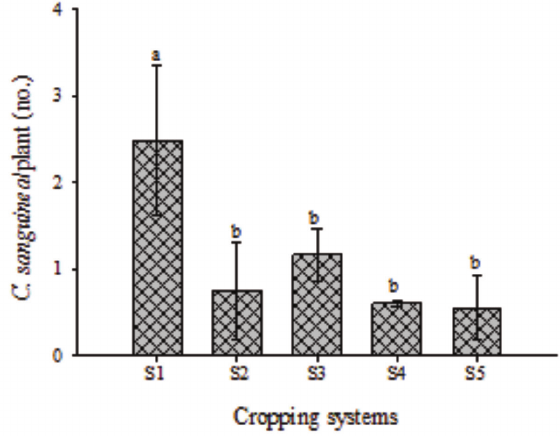
Figure 5 - Mean number (±SE) of Cycloneda sanguinea (Coleoptera: Coccinellidae) per cotton or cowpea plant on the cropping systems of cotton (S4) or cowpea (S5) and cotton intercropped with cowpea systems (S1, S2, and S3). Each column represents the mean number of C. sanguinea on 18 plants. Error bars indicate SE. Different letters indicate differences (SNK test; P =